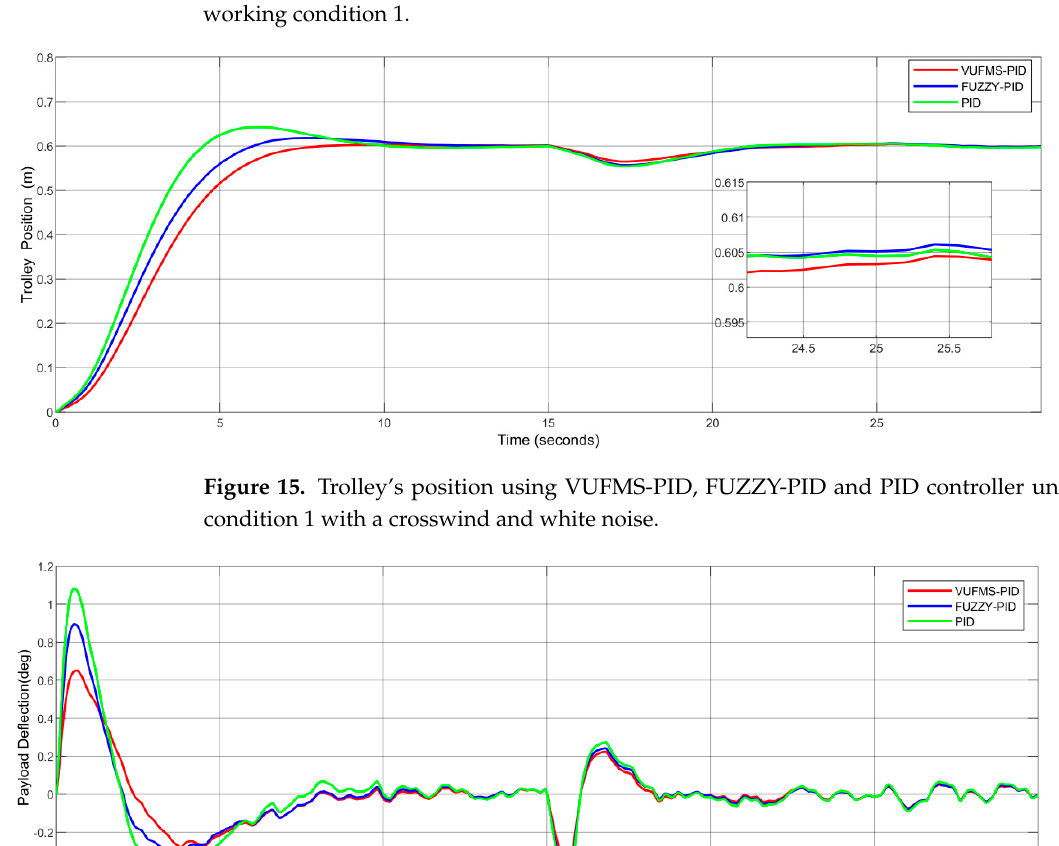
Figure 17. Trolley’s position using VUFMS-PID, FUZZY-PID and PID controller under working condition 2 with a crosswind and white noise. Figure 18. Payload’s swing angle using VUFMS-PID, FUZZY-PID and PID controller under work- ing condition 2 with a crosswind and white noise.